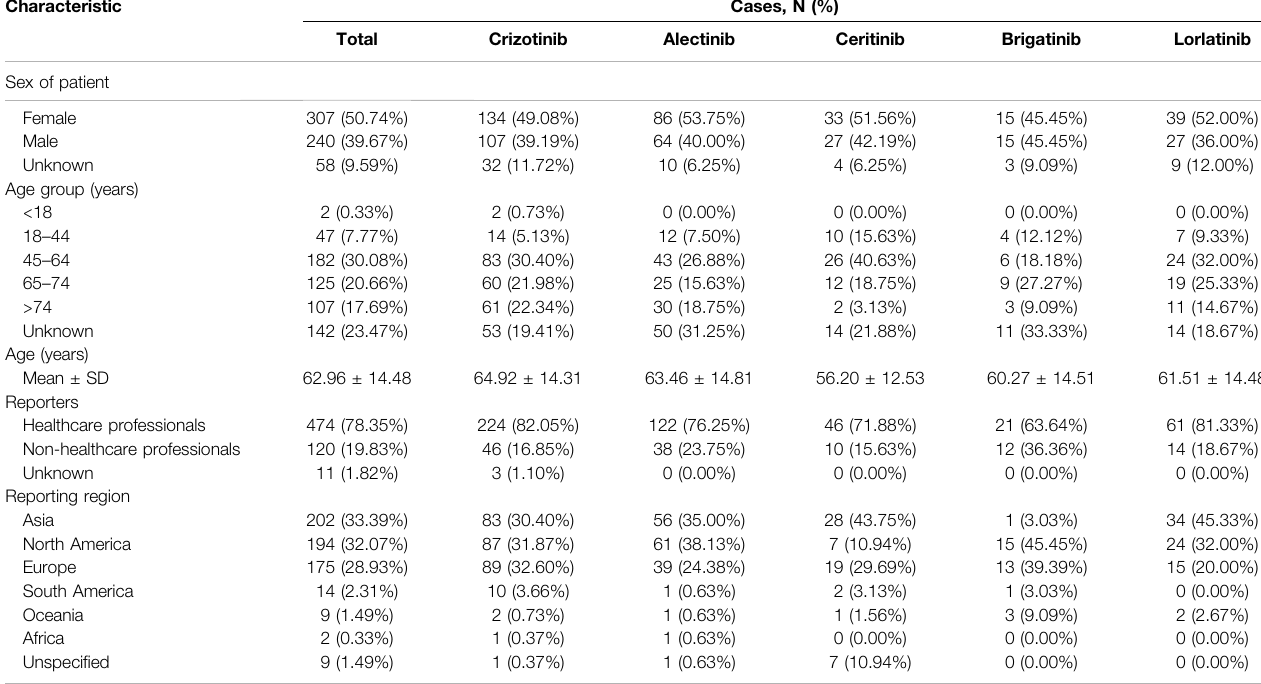
TABLE 1 | Characteristics in ALK-TKI-associated cardiac disorders cases a . Characteristic